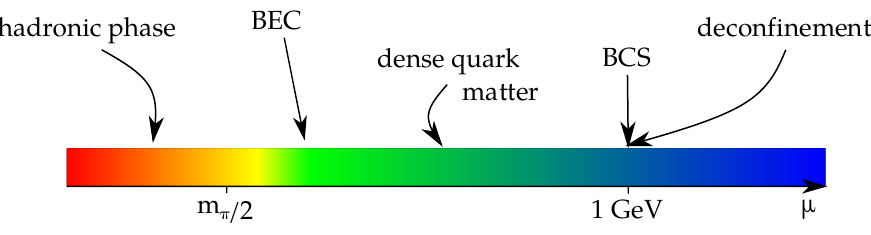
Figure 1 . Schematic phase diagram of dense two-color QCD at low